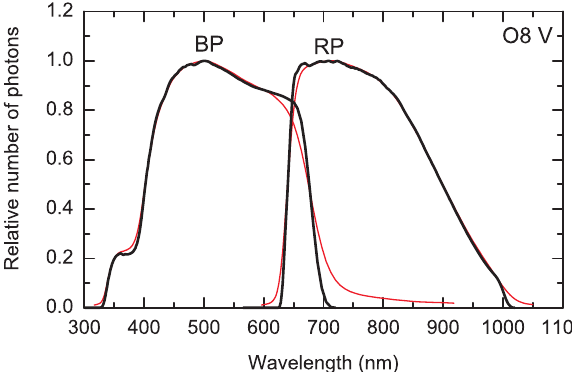
Fig. 1. The Gaia BP and RP spectra for O8 V type star without (black line) and with (red line) the LSF smearing.